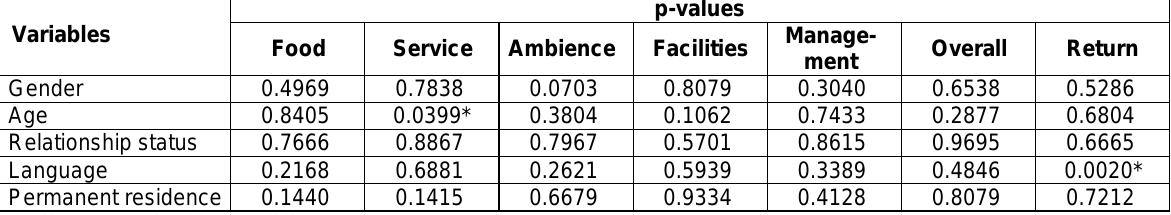
Table 4: The significance of the difference in the means of different demographic groups Variables